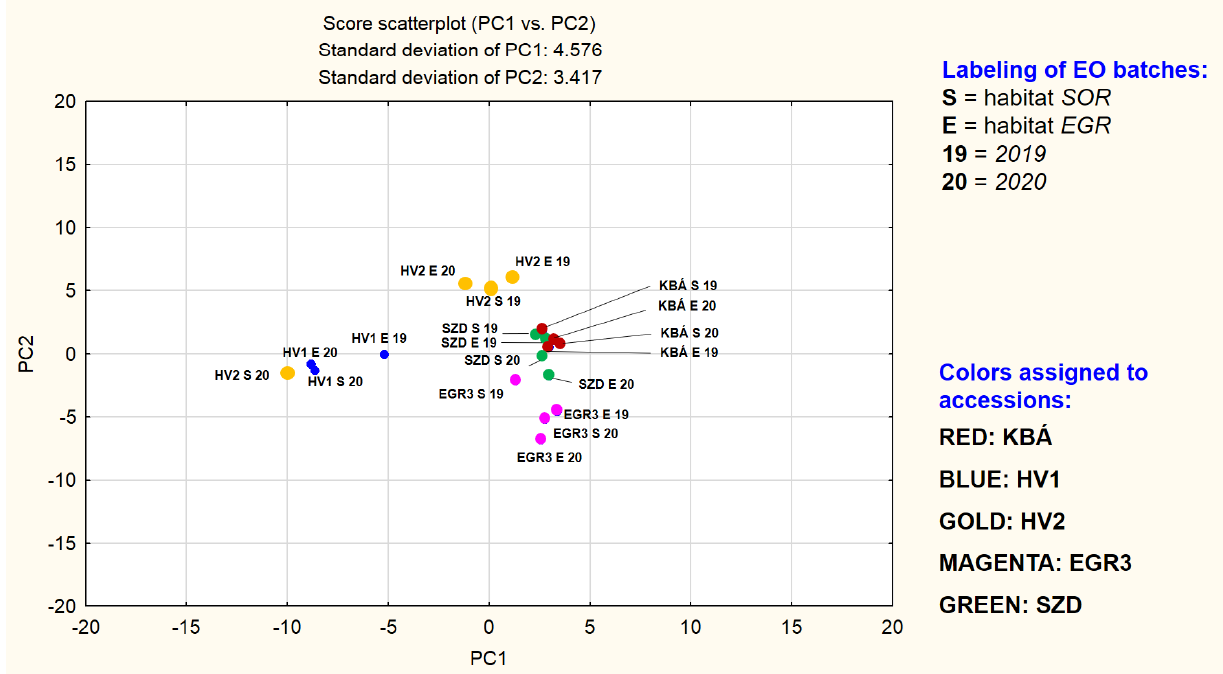
Figure 2. Scatterplot of PC1 vs. PC2.